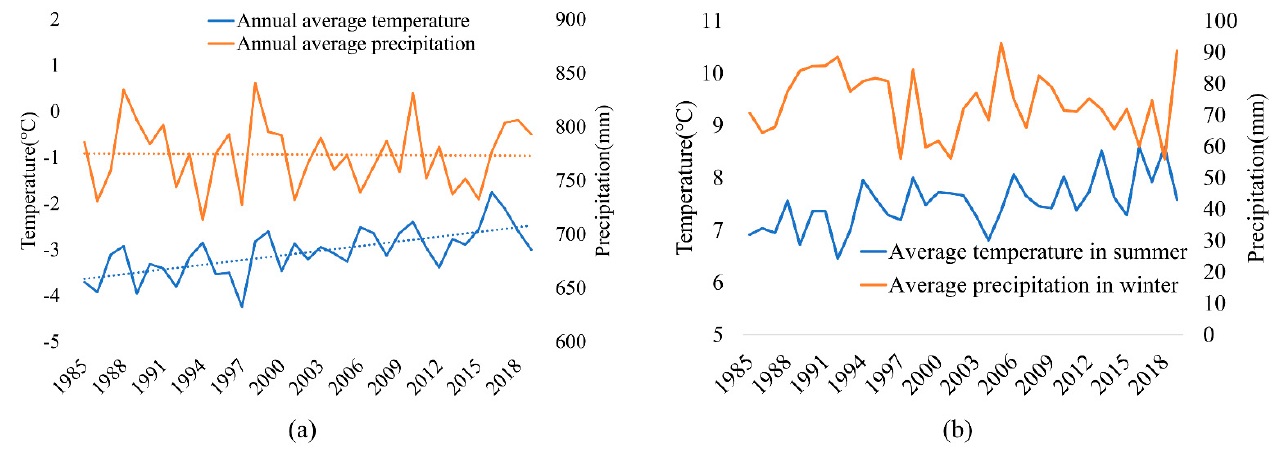
Figure 11. Average annual temperature and precipitation on Tibetan Plateau from 1985 to 2020. ( a ) shows the annual average temperature and precipitation, and ( b ) shows the temperature in summer and precipitation in winter.